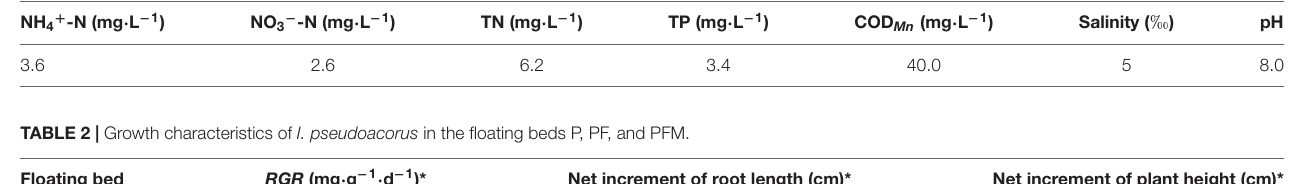
TABLE 1 | The influent components of floating bed in this study.